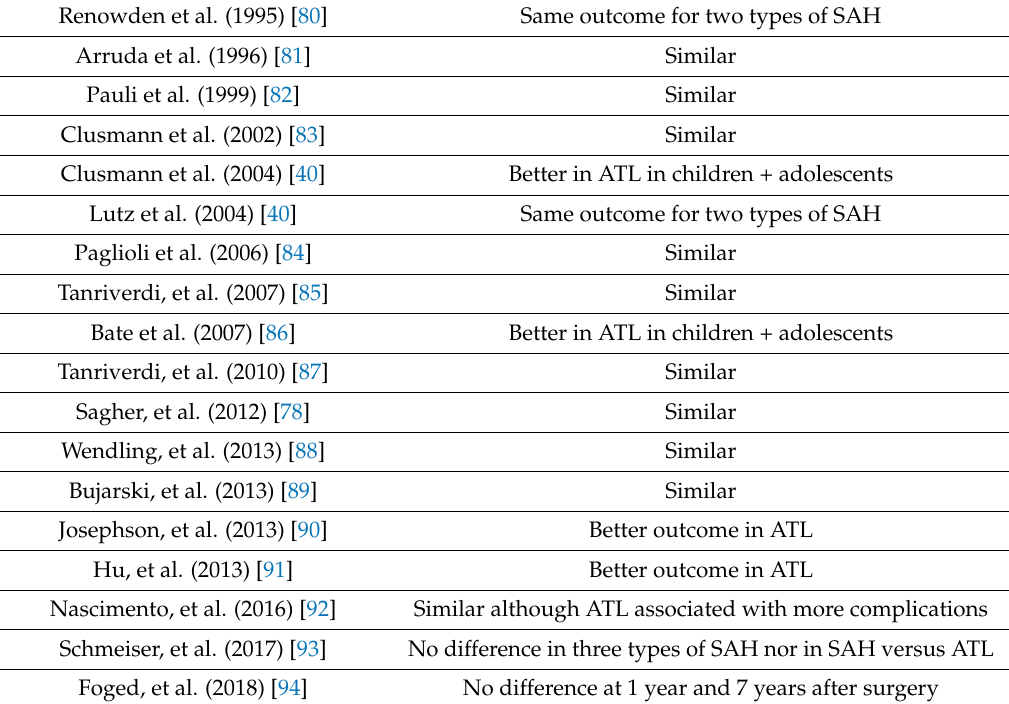
Table 1. Studies comparing ATL with SAH for outcomes of seizure freedom and reducing seizure frequency. Renowden et al. (1995) [80] Same outcome for two types of SAH Similar Similar Better in ATL in children + adolescents Same outcome for two types of